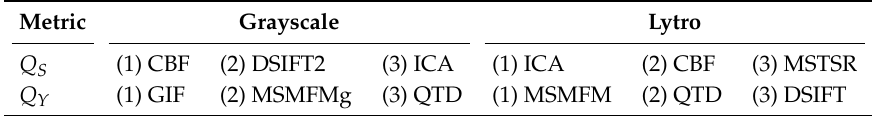
Table 5. Summary of performance evaluation using structural similarity based metrics. For each metric, the numbers (1), (2), and (3) show the three best performing algorithms, respectively. Metric Grayscale Lytro